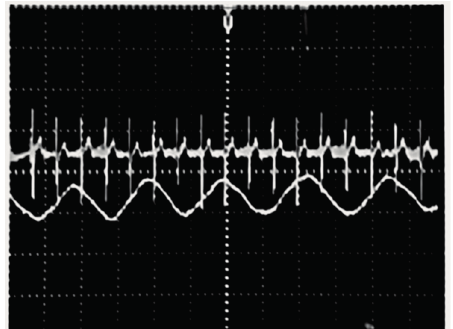
Figure 10. Acquired signals of respiratory rate and